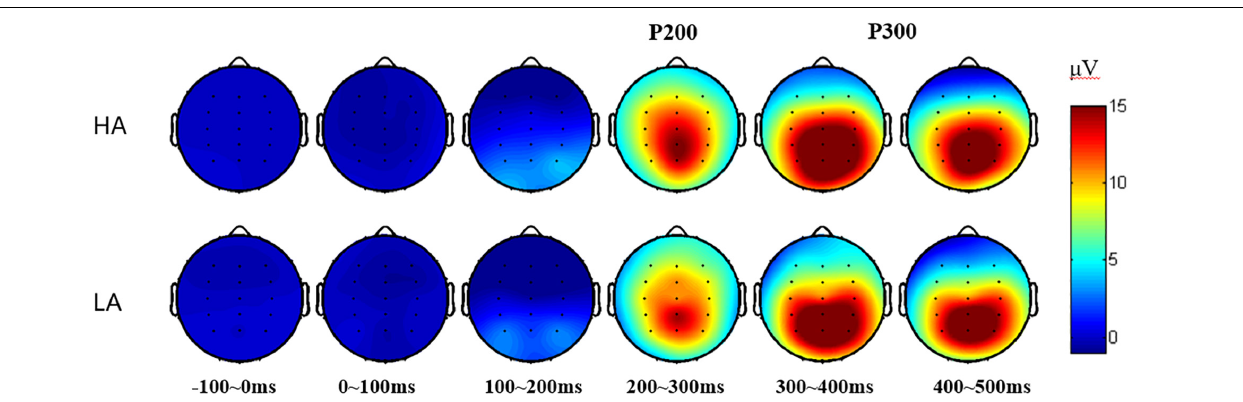
FIGURE 3 | 2-D plot of grand average ERP responses of HA and LA groups from 34 scalp locations (except for four eye electrodes and two reference sites).